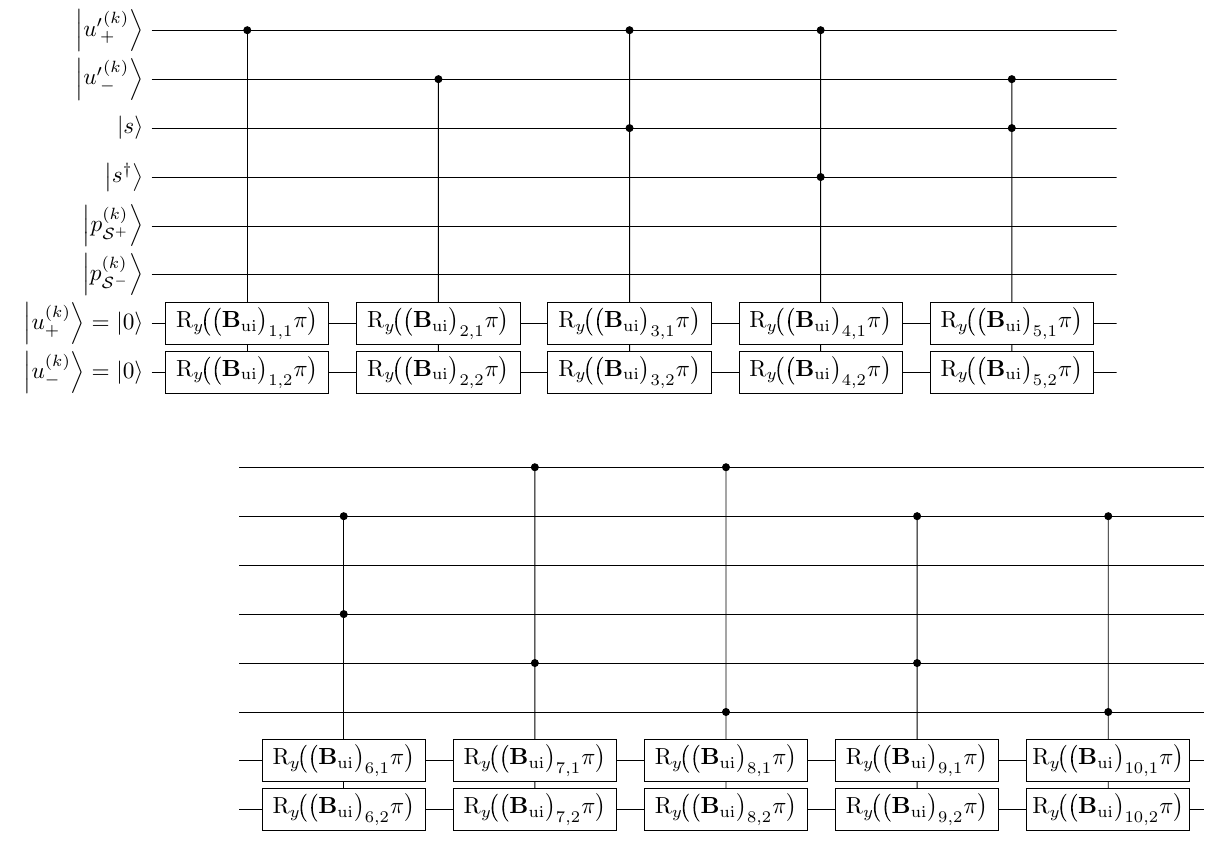
β idt E ( k ) E ( k ) the polar angles of the states and in the Bloch-sphere representation as in Eq. (1). Then the inv , dist | � (cid:31) (cid:31) (cid:30) 1 E ′ ( k ) under measurement is probability of (cid:31) (cid:31) idt = | � (cid:31) (cid:30) (cid:31) where the first term corresponds to the or operation and the second to the successive R y rotations. This is analo- gous to Eq. (S17), justifying the circuit design. Satisfaction. Satisfaction evaluation starts with calculating the expected satisfaction [Eq. (S18)], which is qubit in the quantum algorithm (Table S5). Considering the satisfaction value as a combined state of the involvement–distance trade-off and use intentions, it is modeled as three successive R y rotations conditional to with angles of their respective weights ( σ ′ idt and σ ′ ui / 2 ) of π . This operates on all k (Fig. 11b). Then, the maximum of for different k is found using the maximum search algorithm in Sec- tion “Circuit components for quantum logic”. After the measurement, a definite integer is stored in a classical (cid:30) register, denoting the value of k max [Eq. (S19)]. The value of k max corresponds to the feature that is observed (selected) for the greatest satisfaction and allows for the observed action (see Section S1.3.3). The register then is connected to the evaluation block for the expected satisfaction for action i ( k ) ( ) for each k as the control. (cid:31) (cid:30) The control corresponds to the value of k (see Fig. 3e). The evaluation block for satisfaction value for action i ( k ) (cid:31) ( k max ) 1, 1 u ′ ( k max ) S ( k ) E ( k max ) is the weighted sum of E inv , i (Eqs. (S20) and (S21)]. For ease of comparison, i ∈ [− dist , and ¯ ] is regarded as a unidimensional unipolar scale as if we transform the range to [0, 1]. Then is the neutral point of the scale as the initial state, given by the Hadamard gates (Fig. 11a). It is followed by successive (cid:31) (cid:31) R y rotations with the factors of qubits as the controls and the angles of the respec- 1, 1 u ′ ( k max ) u ′ ( k max ) S ( k ) tive fractions of π/ 2 . Since indicating that i ∈ [− i could contribute negatively to i , and ¯ ] ¯ would be controls for positive and negative angles of R y rotations, respectively. Note that the algorithm is present on the qubits for every k , but due to the classical nature of the k max register, only the evaluation block associated with k max runs eventually. Then, retaining the k register as the control, the